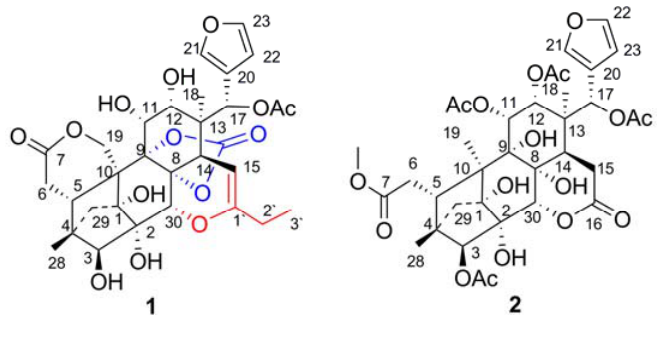
Figure 1. Structures of compounds 1 and 2